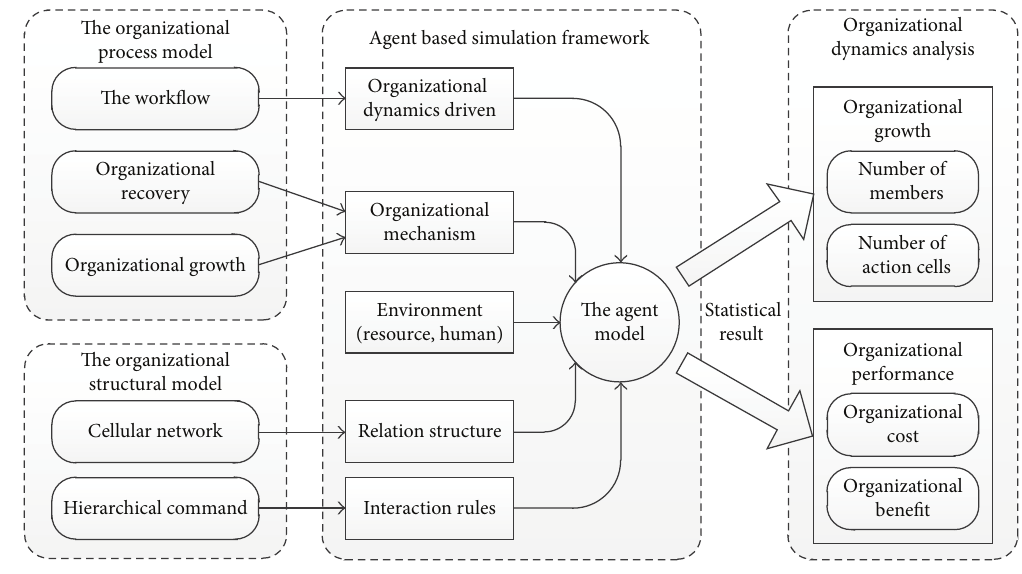
Figure 1: The systematic framework of the research on organizational dynamics of terrorist